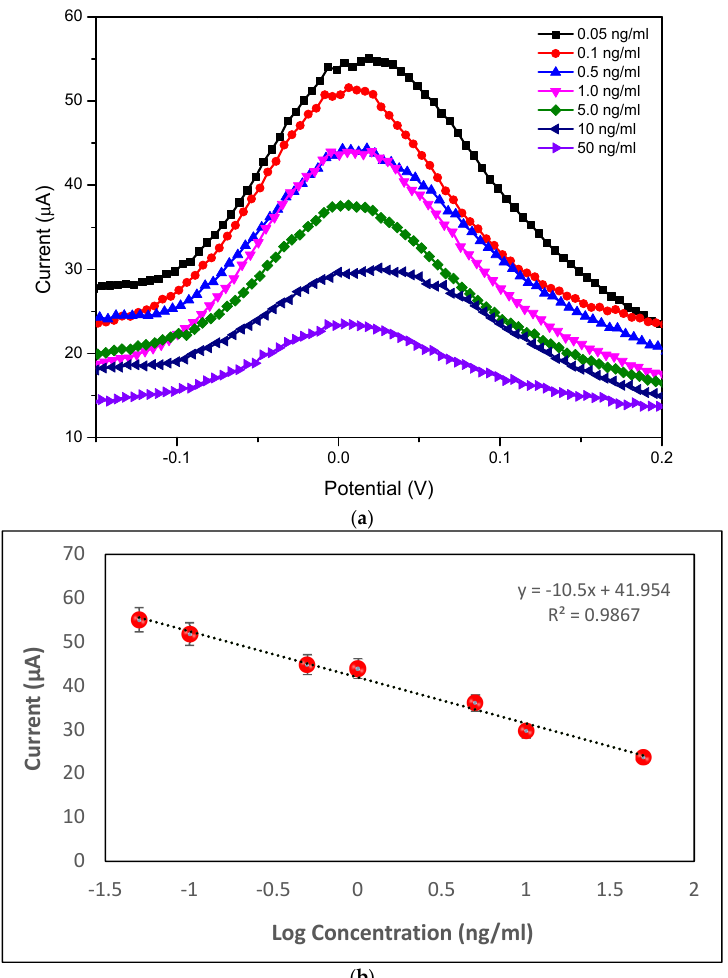
Figure 9. ( a ) DPV response study of MIP-CagA/Au/rGO@SPE with different concentrations of CagA antigen in the presence of [Fe(CN) 6 ] 3 − /4 − electrolytes. ( b ) Representation of the standard calibration curve of MIP-CagA/Au/rGO@SPE with different concentrations of target analytes with reference to DPV